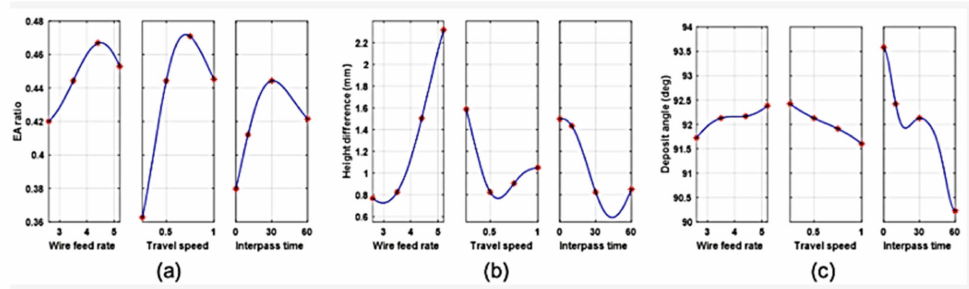
Figure 34. Output values of GPR vs. wire feed rate, travel speed and interpass time: ( a ) EA ratio; ( b ) height difference; ( c ) deposition angle. Reprinted from Ref. [78].